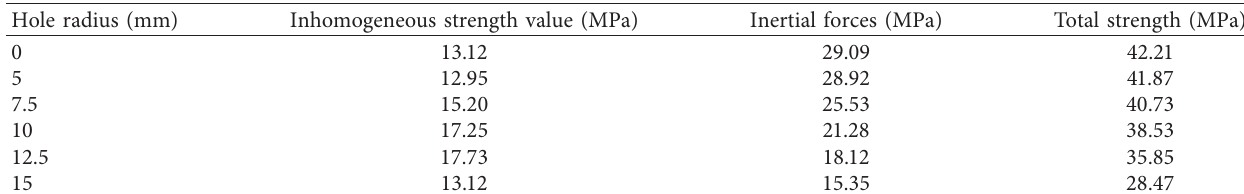
Figure 14: Failure pattern of different hole Table 4: Model strength of different hole radius.